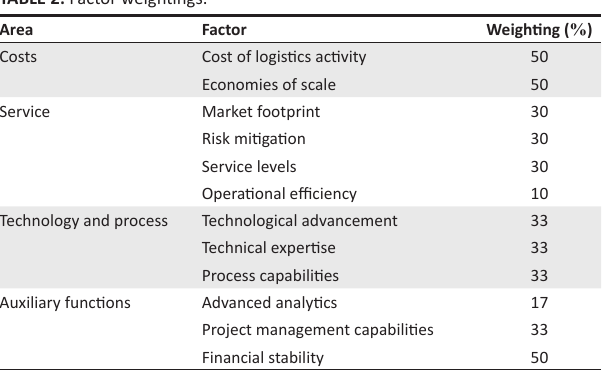
TABLE 2: Factor weightings.